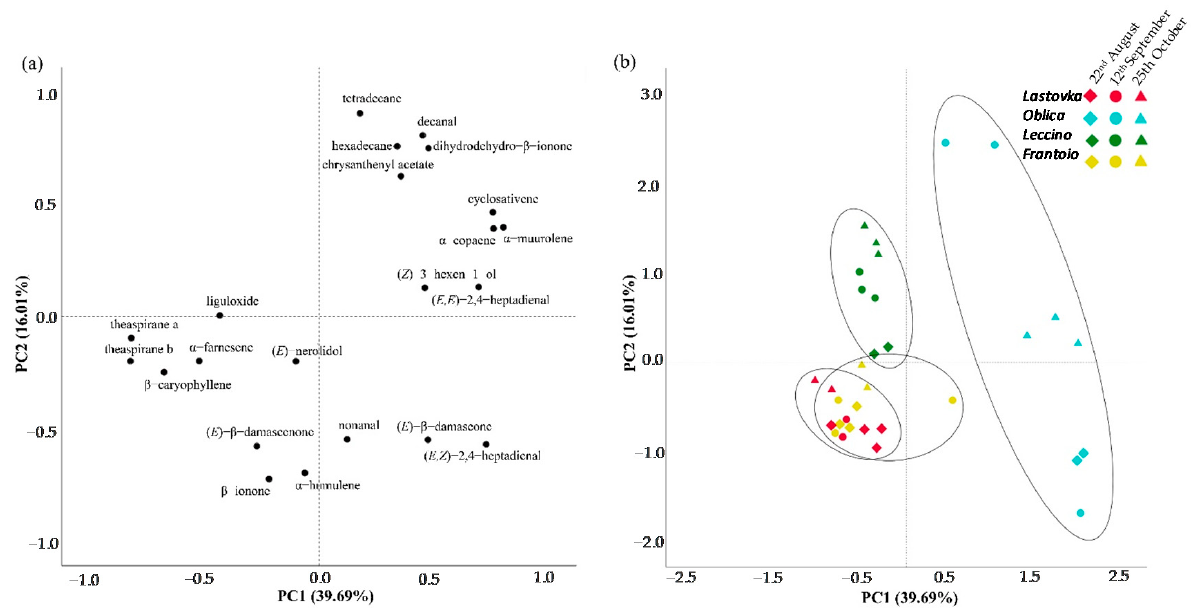
Figure 2. Principal component analysis (PCA) of the volatiles in the amount larger than 2% from cvs. Lastovka, Oblica, Leccino and Frantoio at different harvest periods. ( a ) PCA loading plots of volatiles from the first and second principal component; ( b ) PCA score plot allocating different cultivars into clusters .